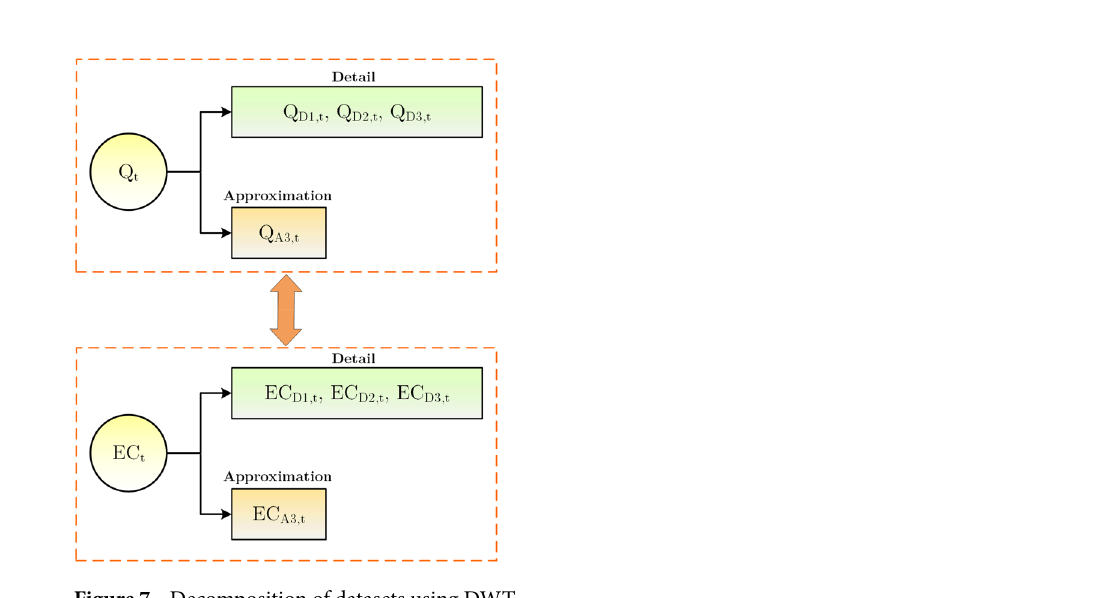
Figure 7. Decomposition of datasets using